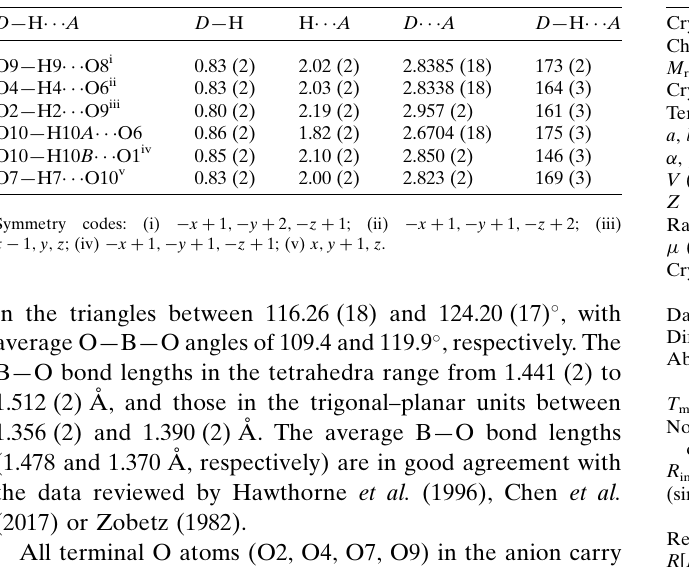
Table 1 Hydrogen-bond geometry (A˚ , (cid:3) ).